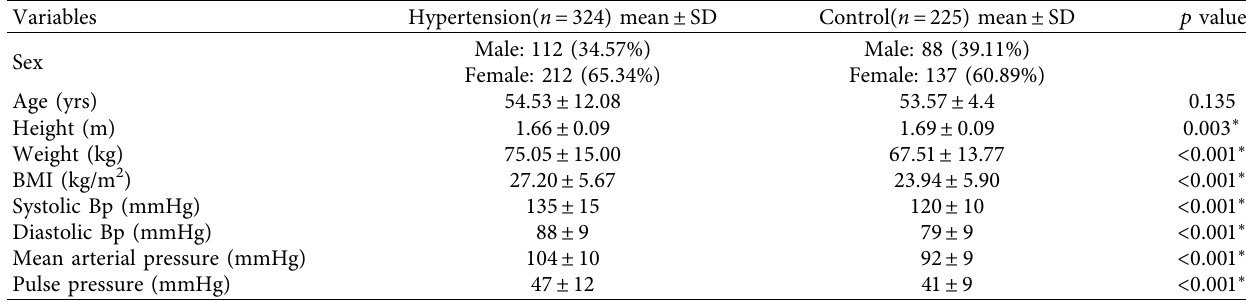
Table 1: Sociodemographic characteristics of